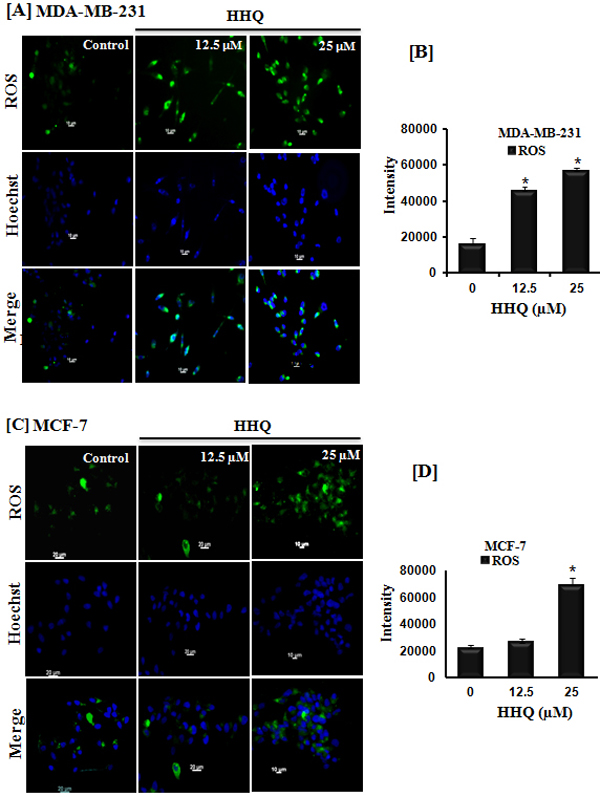
HHQ induced intracellular ROS production in human breast cancer cells, MDA-MB-231 [A] and MCF-7 [C]. The breast cancer cells were treated with 12.5 μM and 25 μM of HHQ for 48 h at 37 °C, intracellular ROS was detected by a fluorescent microscope. Quantitation of the ROS signals in MDA-MB-231 and MCF-7 is shown in [B] and [D], respectively. Significant increase in ROS level was observed in HHQ treated cells. Data are representative of three independent experiments done in triplicates and expressed as mean ± S.E.M. Increase in ROS generation in HHQ treated groups with 12.5 μM and 25 μM were statistically significant (*P<0.05).